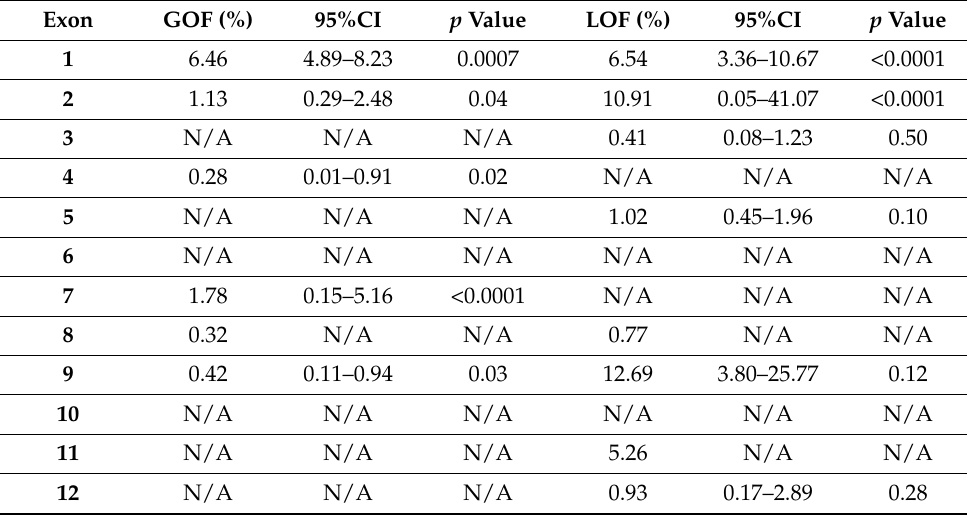
Table 5. The distribution analysis of functional variants on twelve